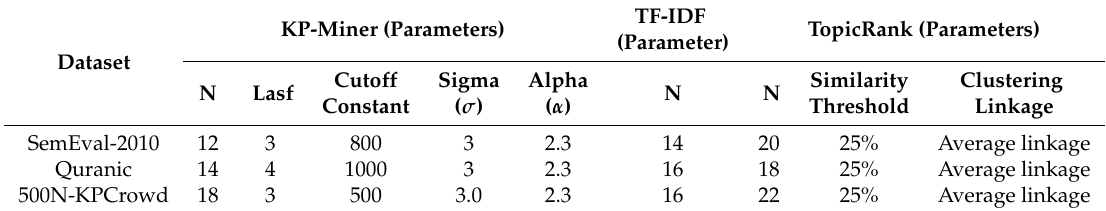
Table 2. Best Parameter values setting on the selected datasets.